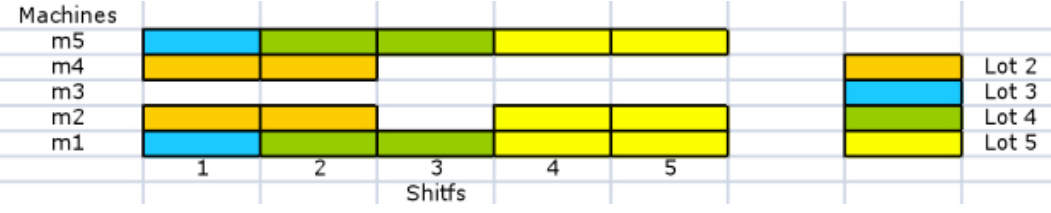
Figure 5. “Solution obtained by scheduling model for instance number 5". Source: